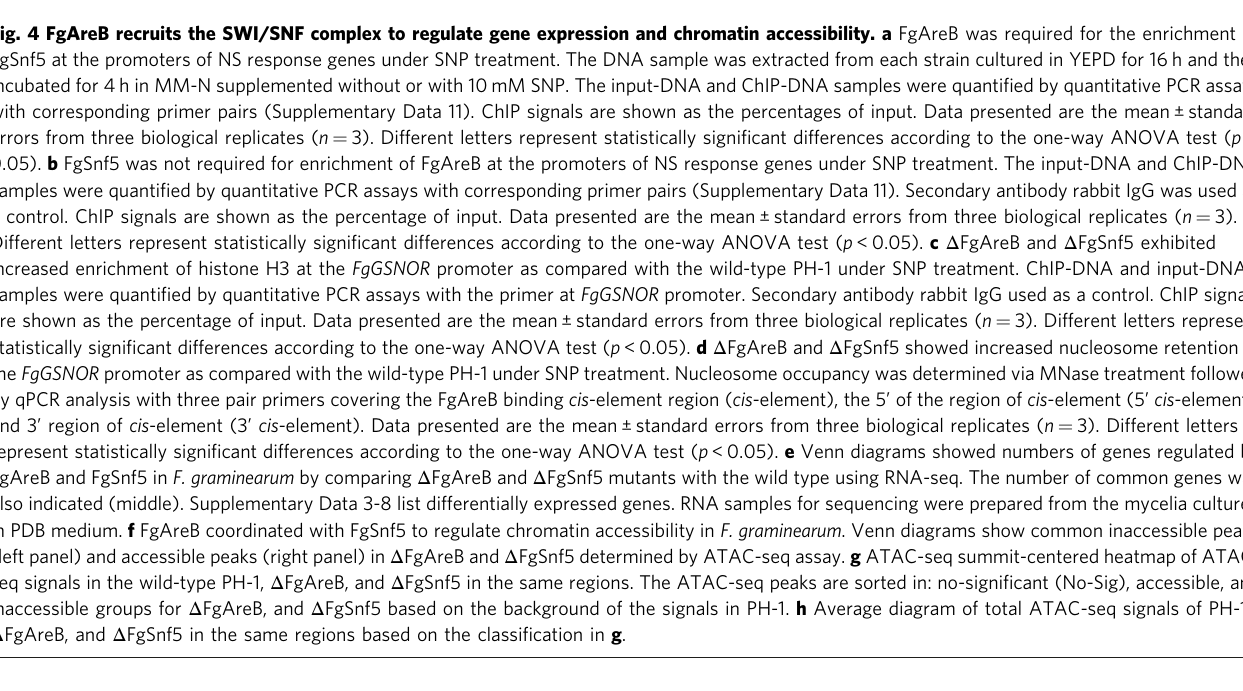
Fig. 4 FgAreB recruits the SWI/SNF complex to regulate gene expression and chromatin accessibility. a FgAreB was required for the enrichment of FgSnf5 at the promoters of NS response genes under SNP treatment. The DNA sample was extracted from each strain cultured in YEPD for 16 h and then incubated for 4 h in MM-N supplemented without or with 10 mM SNP. The input-DNA and ChIP-DNA samples were quanti fi ed by quantitative PCR assays with corresponding primer pairs (Supplementary Data 11). ChIP signals are shown as the percentages of input. Data presented are the mean ± standard errors from three biological replicates ( n = 3). Different letters represent statistically signi fi cant differences according to the one-way ANOVA test ( p < 0.05). b FgSnf5 was not required for enrichment of FgAreB at the promoters of NS response genes under SNP treatment. The input-DNA and ChIP-DNA samples were quanti fi ed by quantitative PCR assays with corresponding primer pairs (Supplementary Data 11). Secondary antibody rabbit IgG was used as a control. ChIP signals are shown as the percentage of input. Data presented are the mean ± standard errors from three biological replicates ( n = 3). Different letters represent statistically signi fi cant differences according to the one-way ANOVA test ( p < 0.05). c Δ FgAreB and Δ FgSnf5 exhibited increased enrichment of histone H3 at the FgGSNOR promoter as compared with the wild-type PH-1 under SNP treatment. ChIP-DNA and input-DNA samples were quanti fi ed by quantitative PCR assays with the primer at FgGSNOR promoter. Secondary antibody rabbit IgG used as a control. ChIP signals are shown as the percentage of input. Data presented are the mean ± standard errors from three biological replicates ( n = 3). Different letters represent statistically signi fi cant differences according to the one-way ANOVA test ( p < 0.05). d Δ FgAreB and Δ FgSnf5 showed increased nucleosome retention at the FgGSNOR promoter as compared with the wild-type PH-1 under SNP treatment. Nucleosome occupancy was determined via MNase treatment followed by qPCR analysis with three pair primers covering the FgAreB binding cis -element region ( cis -element), the 5 ’ of the region of cis -element (5 ’ cis -element), and 3 ’ region of cis -element (3 ’ cis- element). Data presented are the mean ± standard errors from three biological replicates ( n = 3). Different letters represent statistically signi fi cant differences according to the one-way ANOVA test ( p < 0.05). e Venn diagrams showed numbers of genes regulated by FgAreB and FgSnf5 in F. graminearum by comparing Δ FgAreB and Δ FgSnf5 mutants with the wild type using RNA-seq. The number of common genes was also indicated (middle). Supplementary Data 3-8 list differentially expressed genes. RNA samples for sequencing were prepared from the mycelia cultured in PDB medium. f FgAreB coordinated with FgSnf5 to regulate chromatin accessibility in F. graminearum . Venn diagrams show common inaccessible peaks (left panel) and accessible peaks (right panel) in Δ FgAreB and Δ FgSnf5 determined by ATAC-seq assay. g ATAC-seq summit-centered heatmap of ATAC- seq signals in the wild-type PH-1, Δ FgAreB, and Δ FgSnf5 in the same regions. The ATAC-seq peaks are sorted in: no-signi fi cant (No-Sig), accessible, and inaccessible groups for Δ FgAreB, and Δ FgSnf5 based on the background of the signals in PH-1. h Average diagram of total ATAC-seq signals of PH-1, Δ FgAreB, and Δ FgSnf5 in the same regions based on the classi fi cation in g